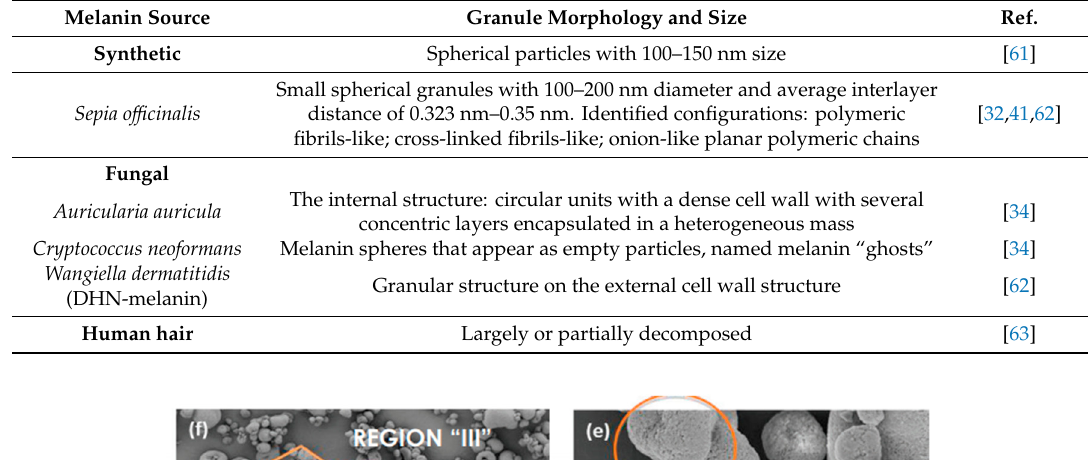
Table 4. TEM analysis of di ff erent types of melanin.